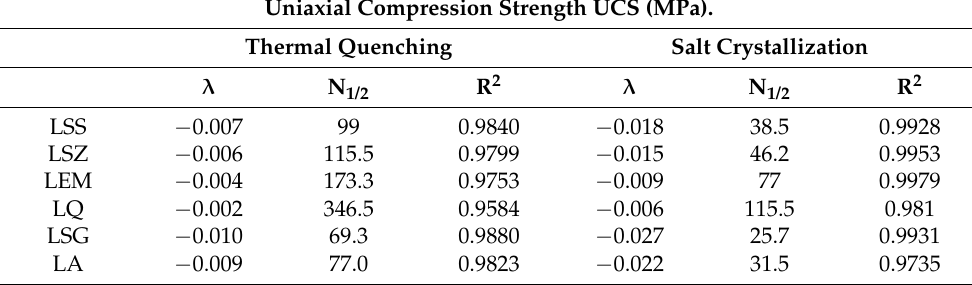
Table 7. Decay constant ( λ ), half-life (N 1/2 ), and coefficient of determination (R 2 ) of uniaxial com- pression strength parameter due to cyclic thermal shock and salt